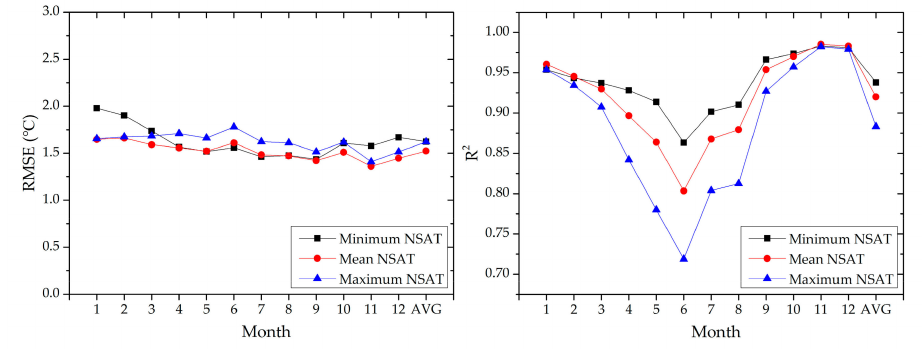
Figure 5. RMSE and R 2 of the predicted monthly minimum, mean, and maximum near surface air temperature using the geographically weighted regression model in China in 12 months of